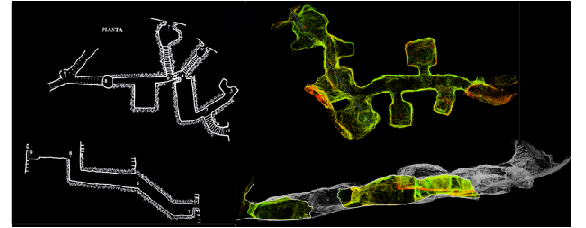
Figure 6. Simple horizontal and front plans (left) and modern representation based on 3D point cloud visualization (right) of the same tunnel.